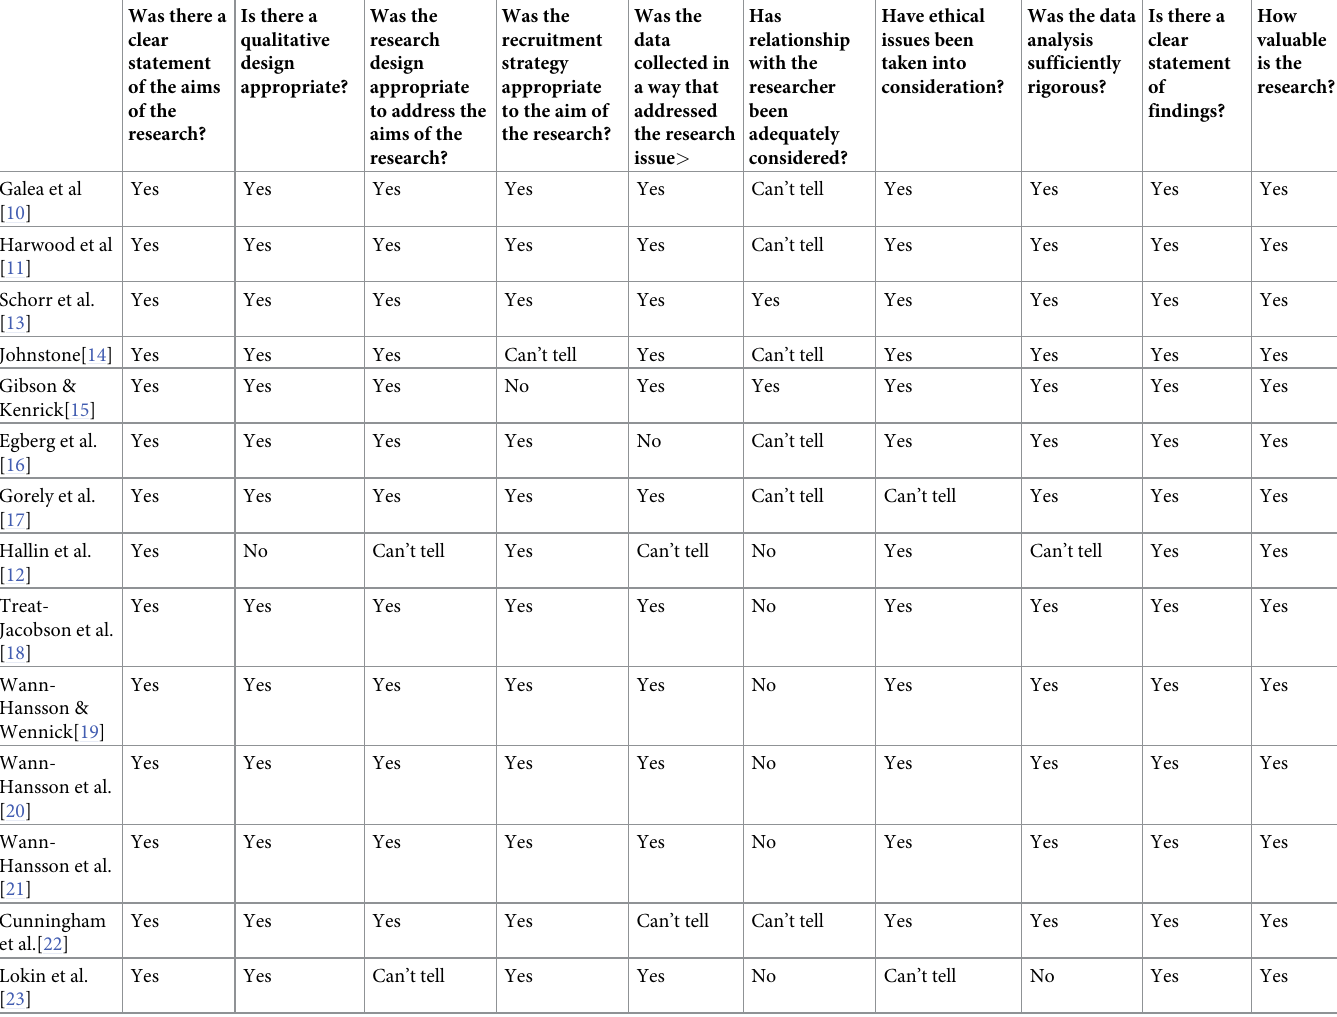
Table 2. Table of quality appraisal of the included studies using the CASP qualitative research checklist. Was there a